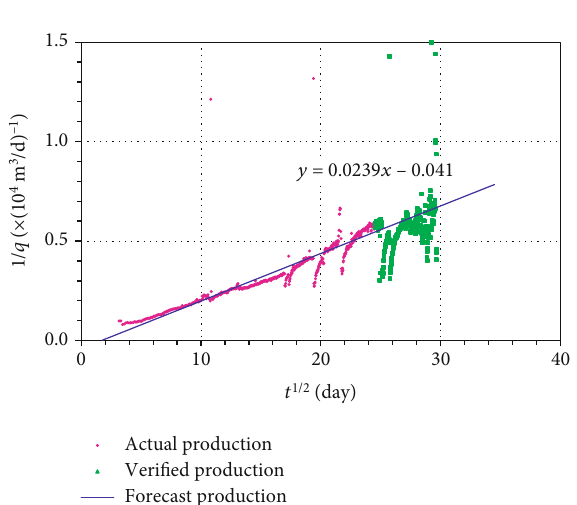
Figure 8: 1/ q vs. t 1/2 matching plot for D g